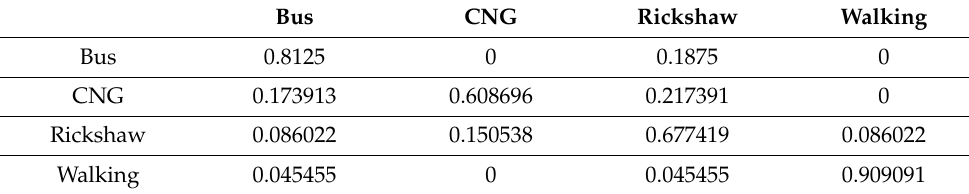
Table 6. Confusion matrix